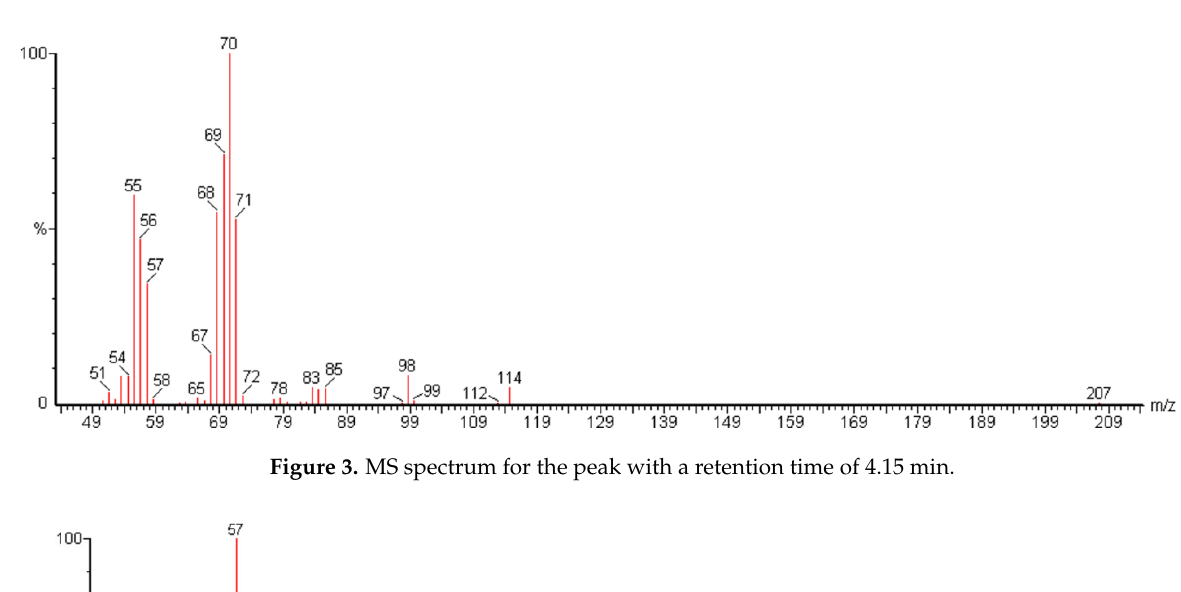
Figure 2. Chromatogram of a sample of diesel oil no. 16, recorded in SIR mode, for three masses: 78 Da, 92 Da, and 106 Da.